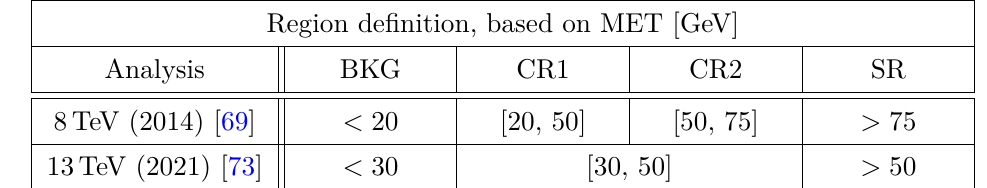
Table 2 . Background (BKG), control (CR) and signal regions (SR) for non-pointing photon searches.